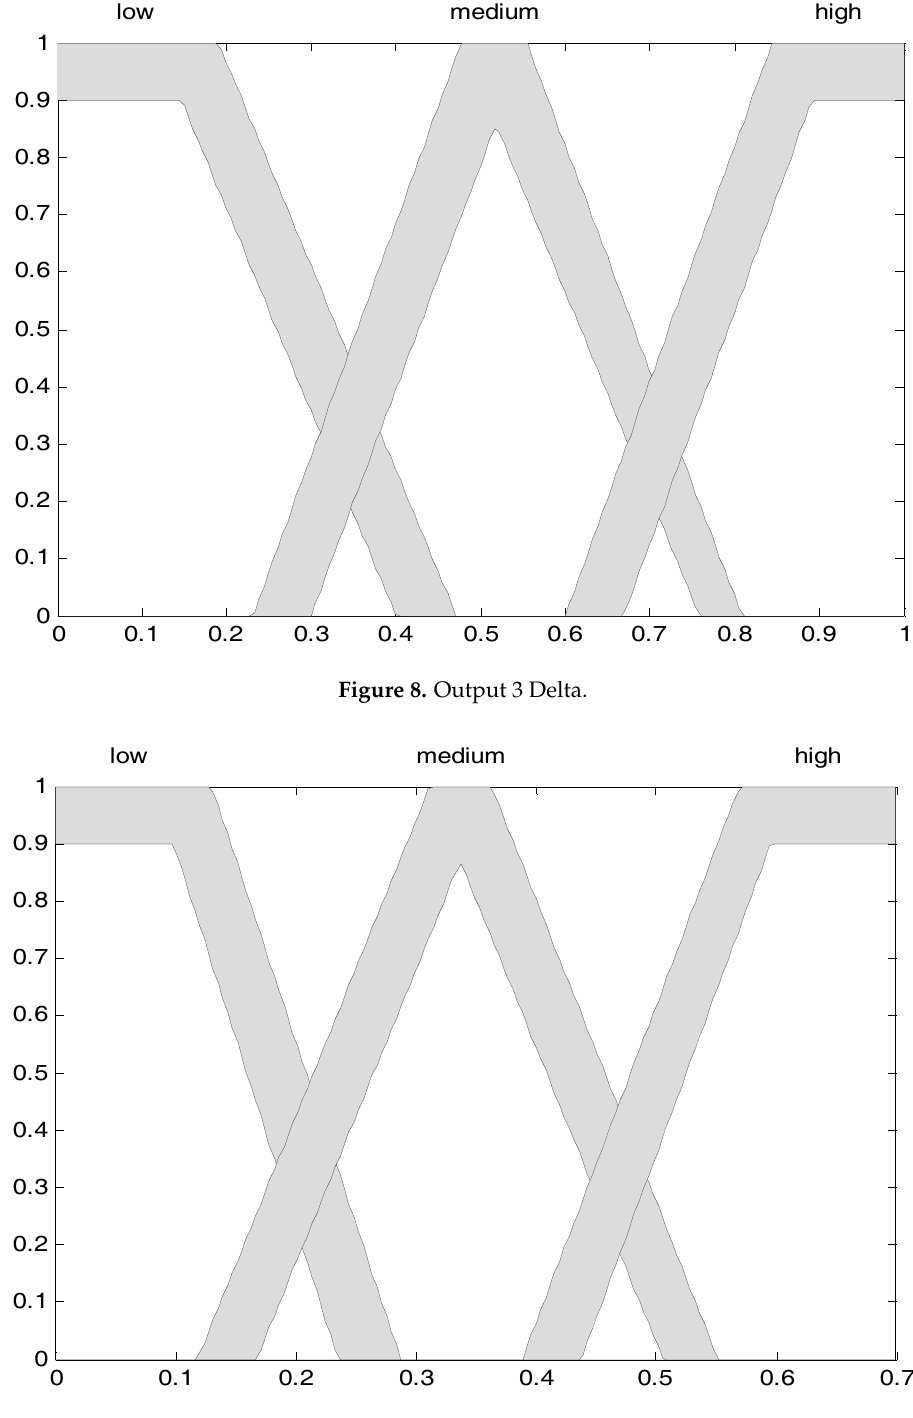
Figure 9. Output 4 Figure 9. Output 4 Lambda. Figure 9. Output 4 Lambda.